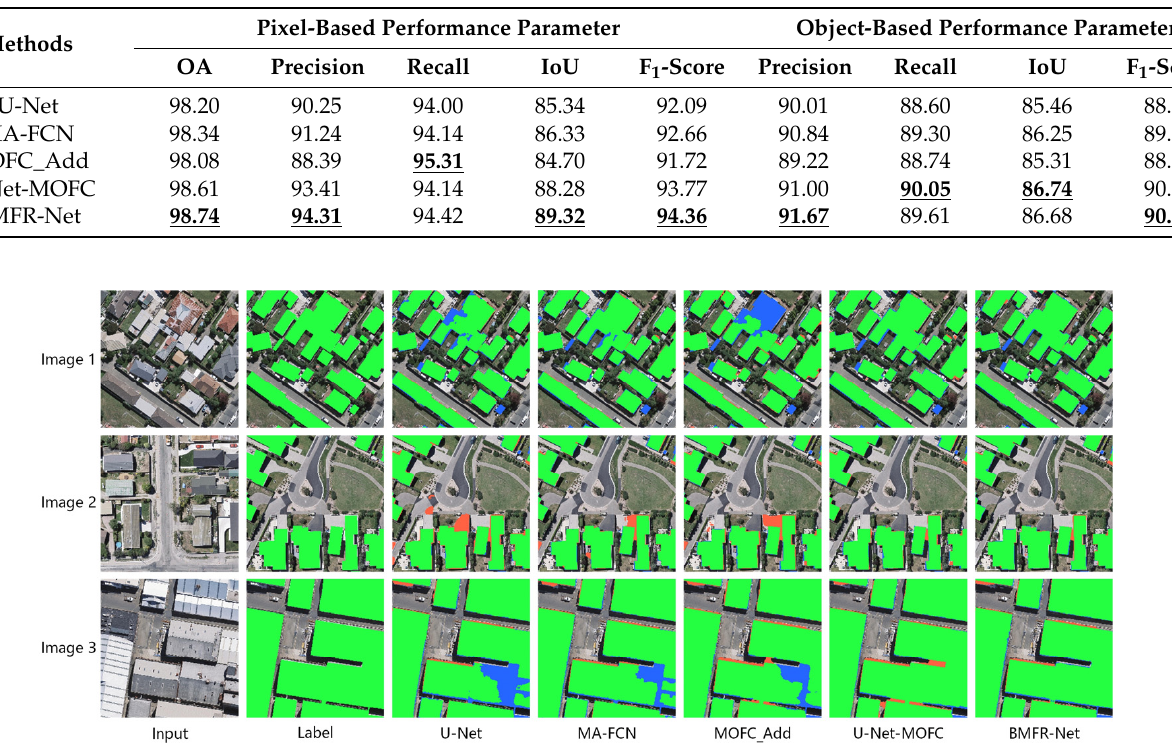
Figure 17. Typical building extraction results of U-Net with different multiscale output fusion constraint structures. In the graph, green represents TP, red represents FP, and blue represents FN.